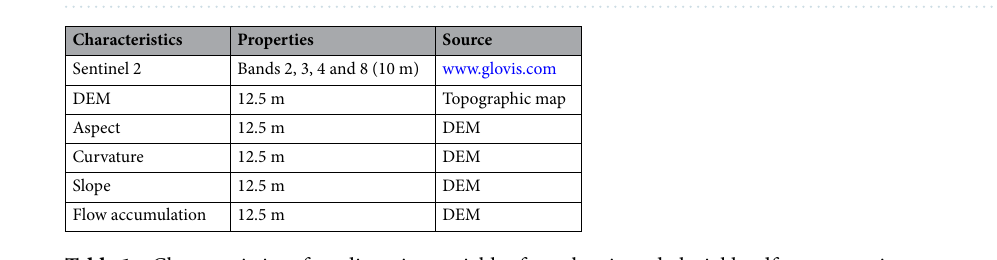
Table 1. Characteristics of predisposing variables for volcanic and glacial landforms